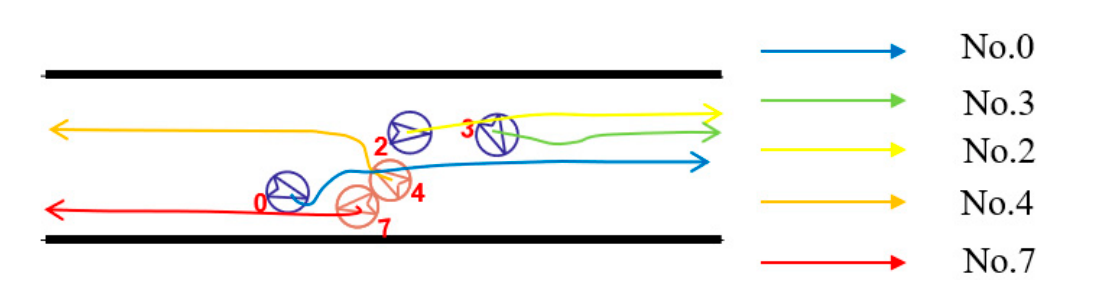
Figure 18. Screenshot of simulation of phase motion.